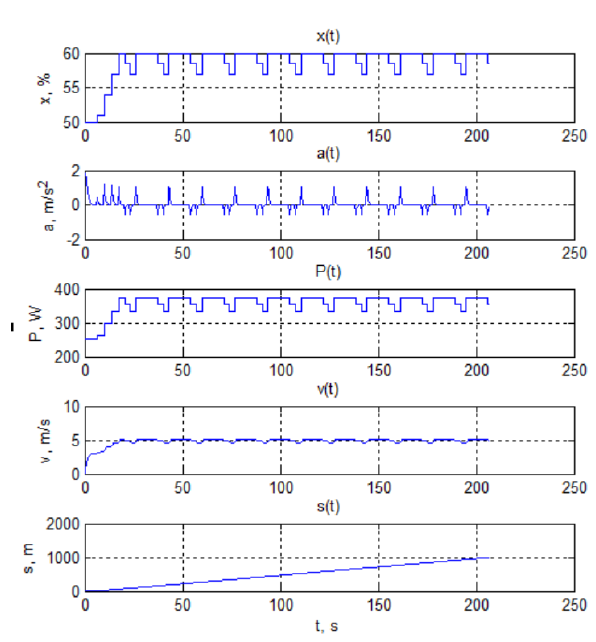
Fig. 9. Dynamics of the UAV with optimal control.